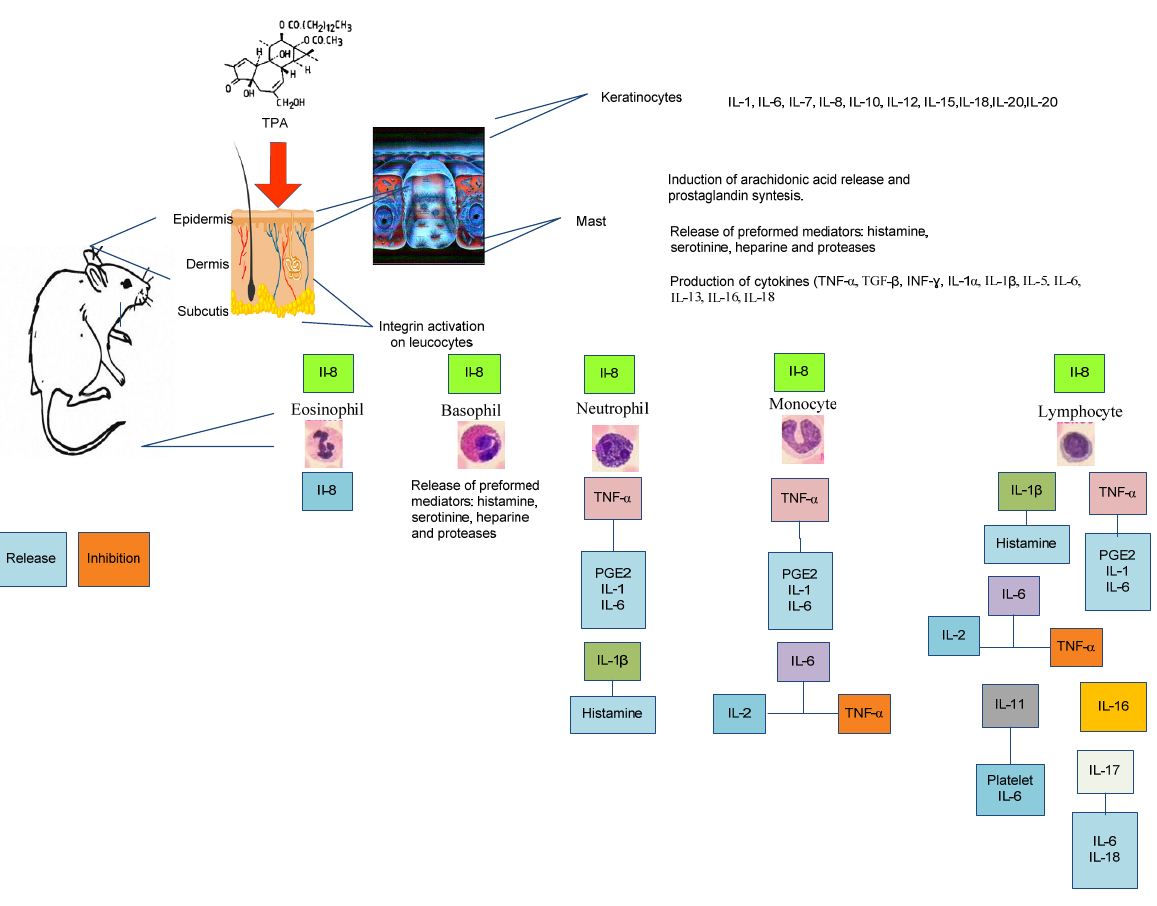
Figure 2. Inflammatory mediators after application of